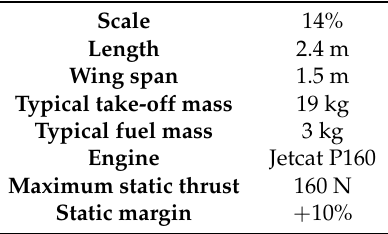
Table 2. Characteristics of the GFF subscale demonstrator during this experiment.